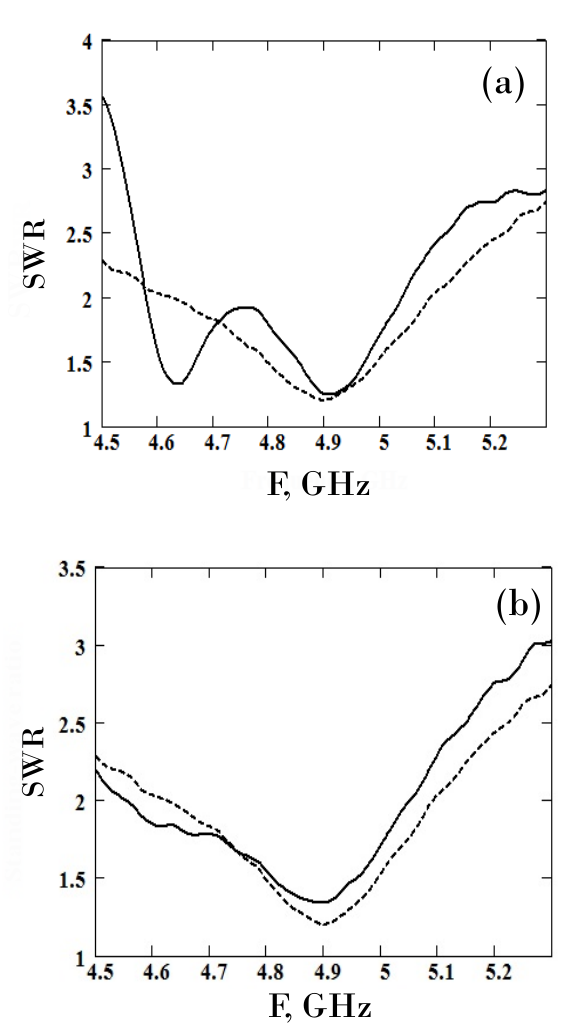
Figure 9. SWRs of C -range horn antennas made from ( a ) Fiber (dashed line) and metal (solid line), and ( b ) Fiber (dashed line) and fabric (solid line).